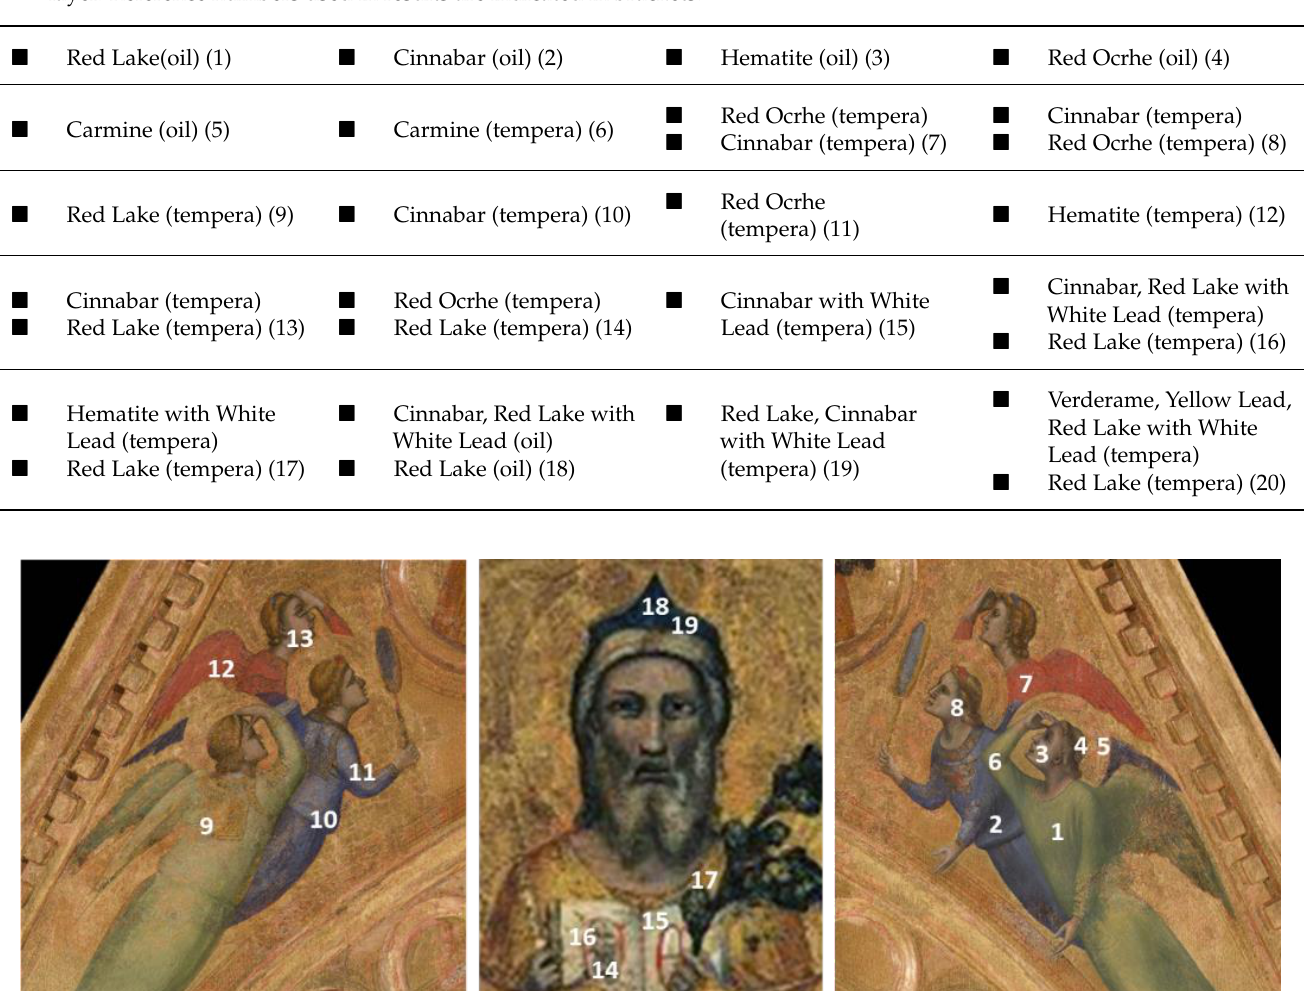
Table 1. Sequences of the pigments used in the reference panel. Every sequence is reported from the bottom to the upper layer. Reference numbers used in results are indicated in brackets.